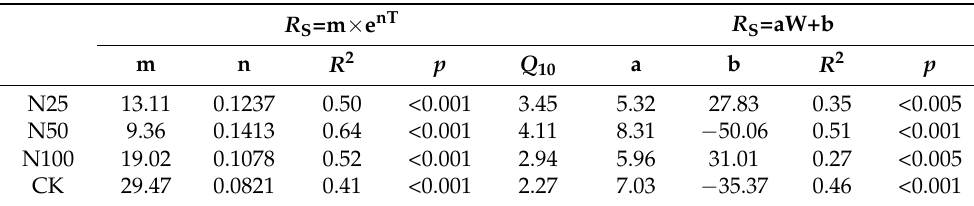
m, n, a, and b are the model coefficients. The Q 10 value is obtained from n ( Q 10 = e 10n ). N25, N50, N100, and CK represent 25, 50, 100, and 0 kg N ha − 1 a − 1 N addition treatments,